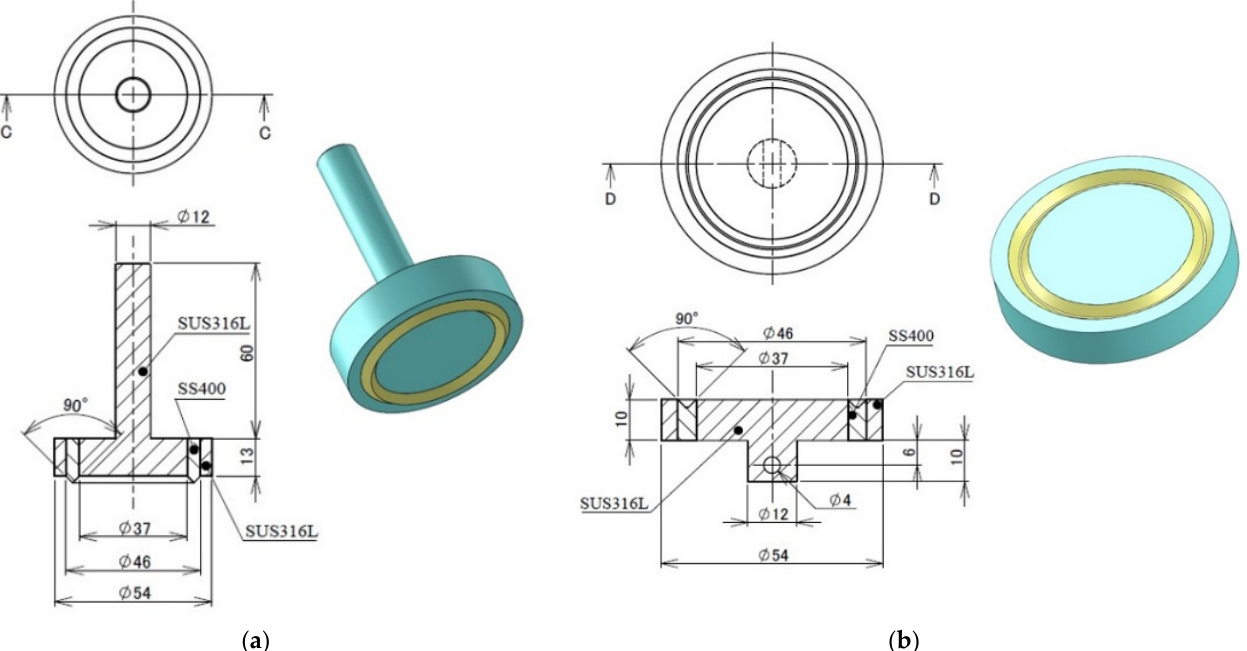
Figure 3. Rotor and stator for the V-shaped plate setting. ( a ) Rotor, ( b ) stator. line C and D are the view points of the